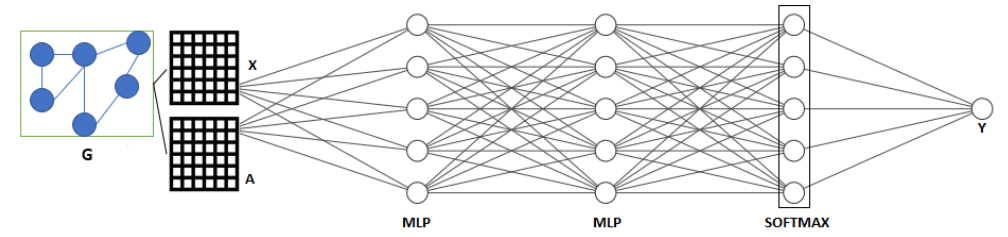
Figure A1. An example of a basic